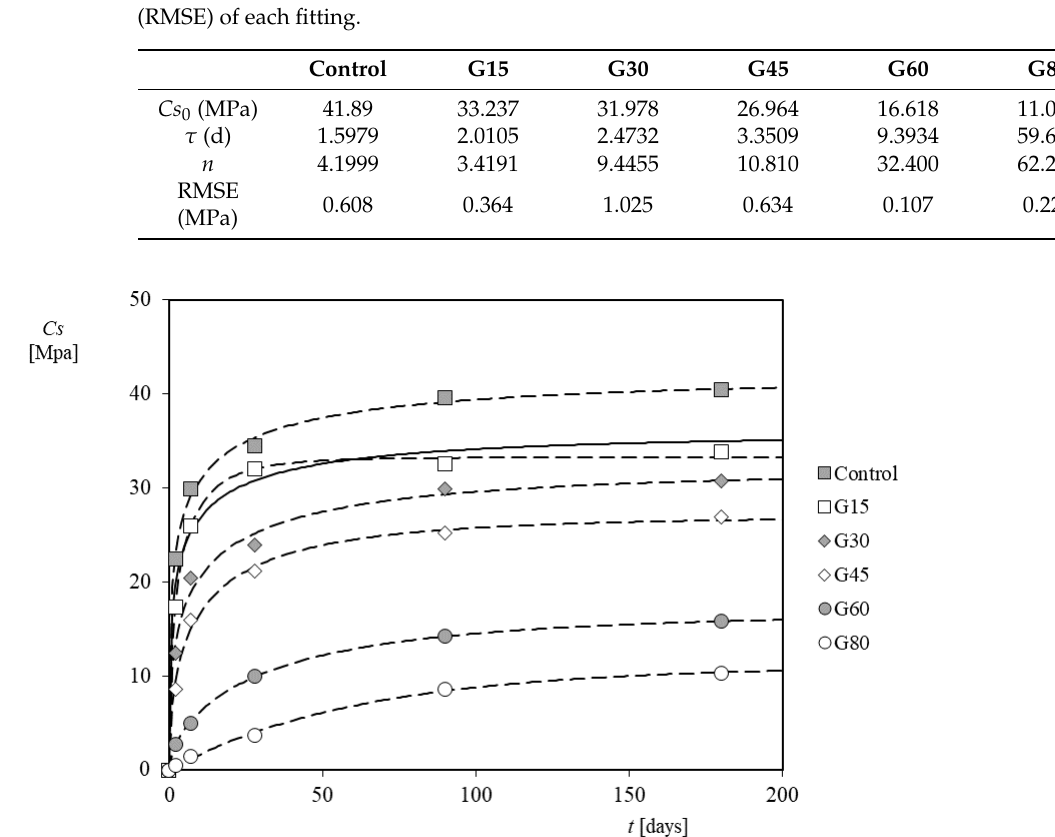
Figure 5. Evolution over time after setting of concrete compression strengths, Cs , for different cases studied (see Tables 1 and 4).